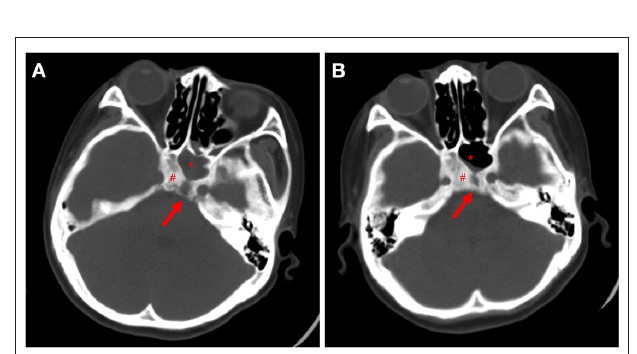
FIGURE 2 | Paranasal sinus caused significant bony erosion. (A) Cranial CT at admission. (B) Cranial CT 1 month later. Red arrows indicate bone destruction. # refer to the clivus, *for sphenoid